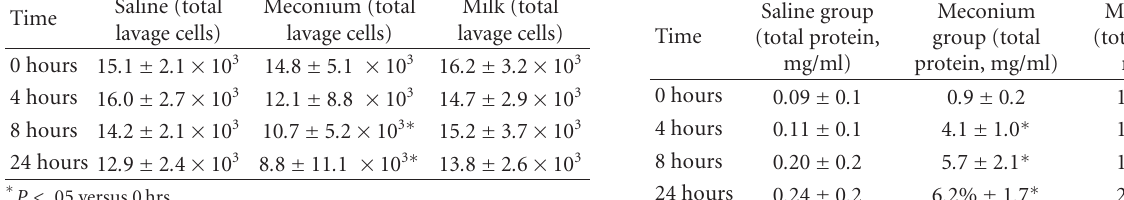
(a) Total lung lavage cell count after exposure to saline, meconium, and (a) Total protein content in lung lavage fluid after exposure to saline, milk. meconium, and milk (mg/ml). Saline (total Meconium (total Milk (total Time lavage cells) lavage cells)